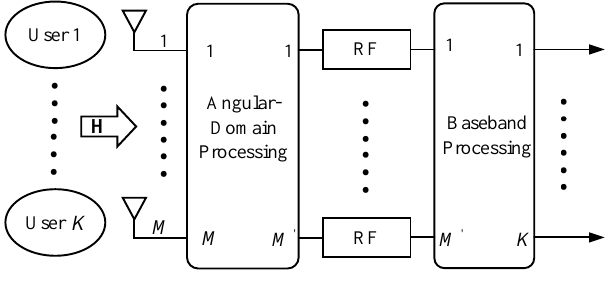
Figure 1. A diagram of angular-domain detection architecture for mmWave massive multiple-input multiple-output (MIMO)